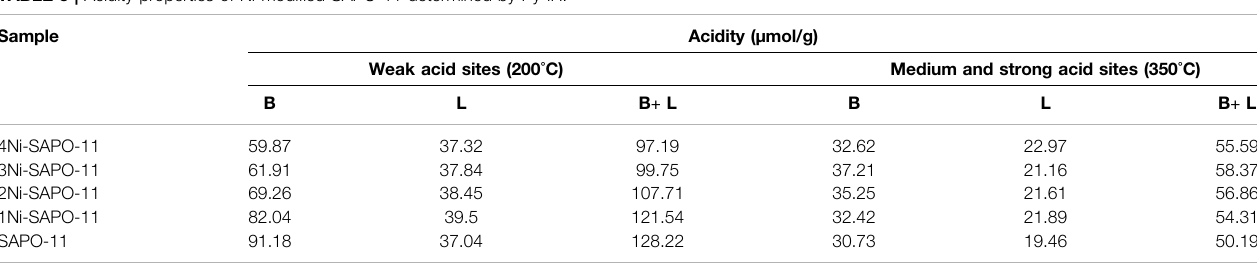
TABLE 3 | Acidity properties of Ni-modi fi ed SAPO-11 determined by Py-IR.